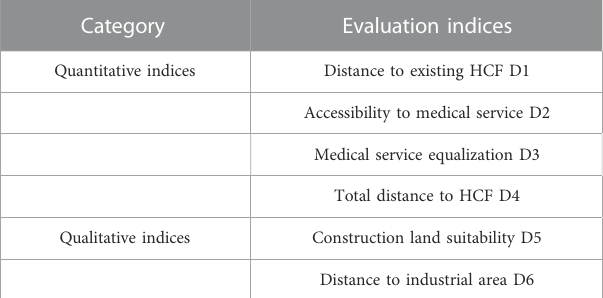
TABLE 3 New healthcare facility site selection evaluation index